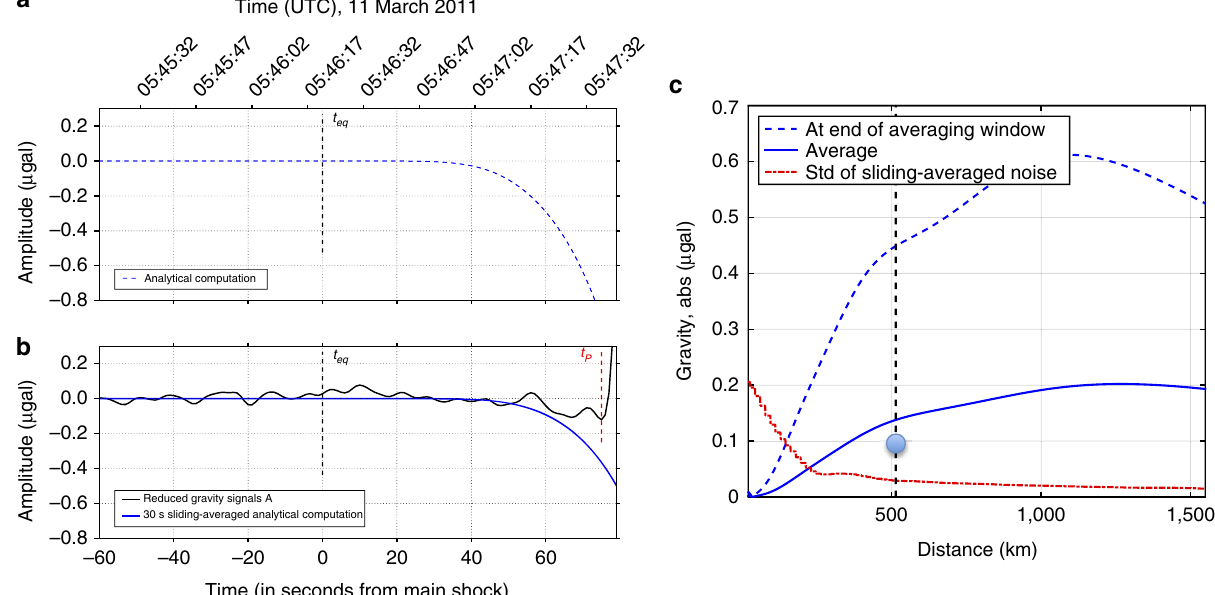
Figure 4 | Comparison between observations and a theoretical model. ( a ) Analytical computation of the gravity perturbation produced at Kamioka by the Tohoku-Oki earthquake. ( b ) The 30s sliding-averaged theoretical prediction (solid blue) and observed reduced gravity signals (black). ( c ) Gravity perturbation near the P-wave arrival, with (solid blue) and without (dashed blue) sliding-average, as a function of distance to the earthquake centroid. The duration of the averaging window is increased with increasing distance to the source. The red line is the standard deviation of the sliding-averaged background noise. The vertical dashed line marks the distance of the Kamioka Observatory, the dot indicates the observed value of the reduced gravity signal at